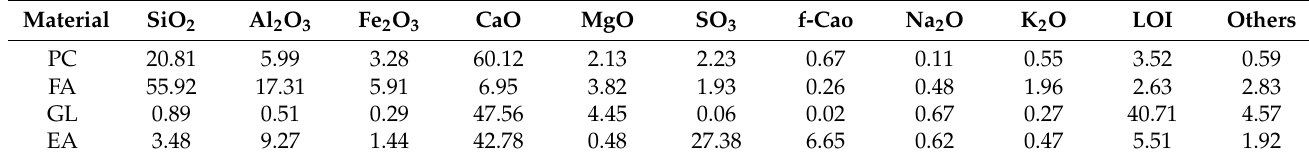
Table 4. Chemical compositions of cementitious materials (unit: %).